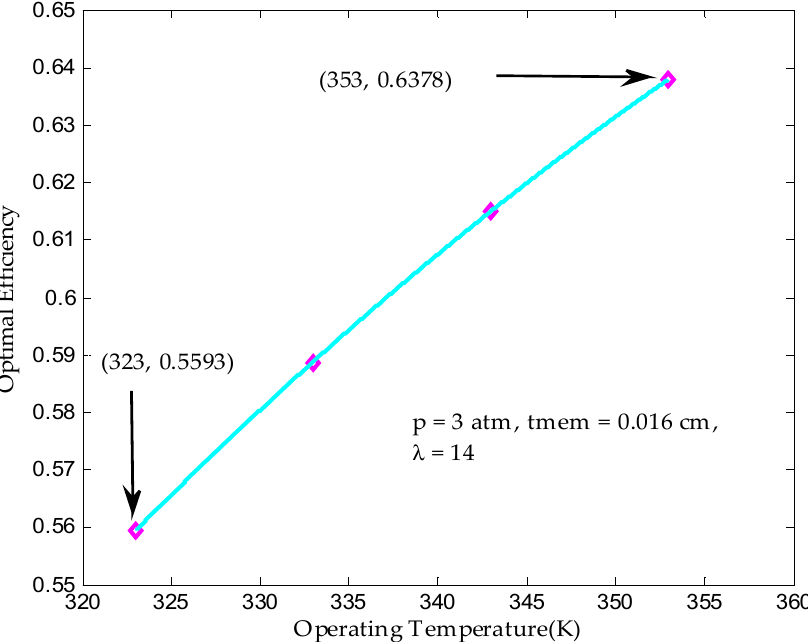
Figure 7. Effect of operating temperature on optimal output efficiency.